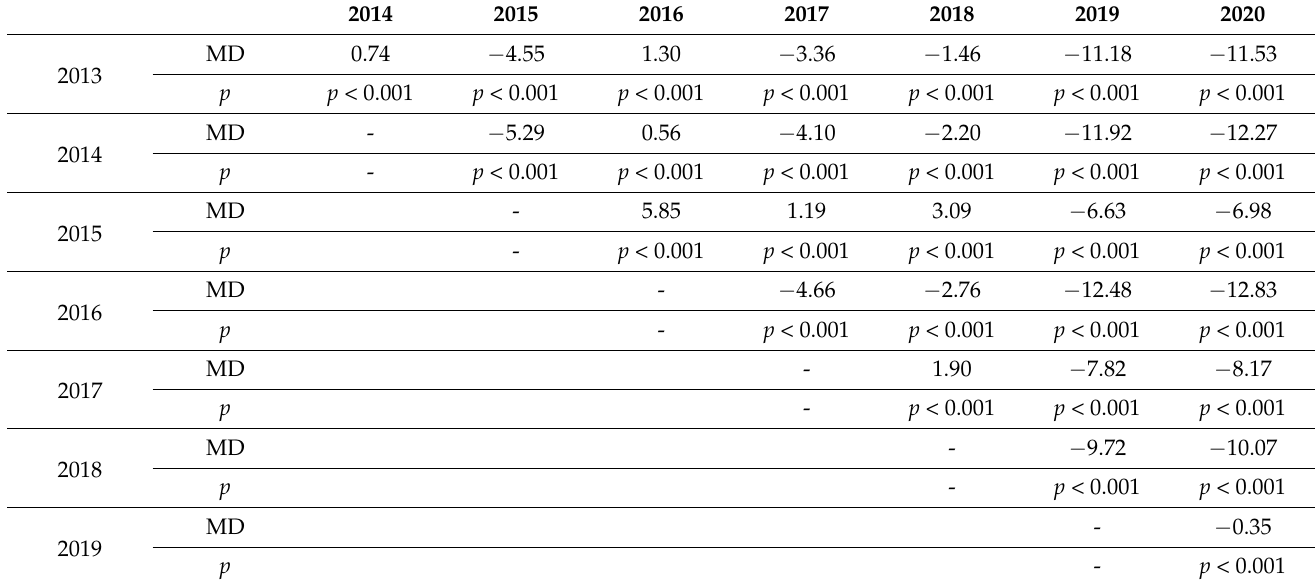
Table 3. Comparison of the duration of CPR cycles between individual editions of the